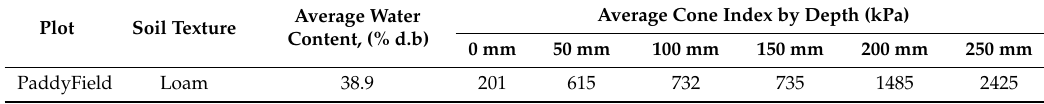
Table 4. Soil properties of the paddy field.